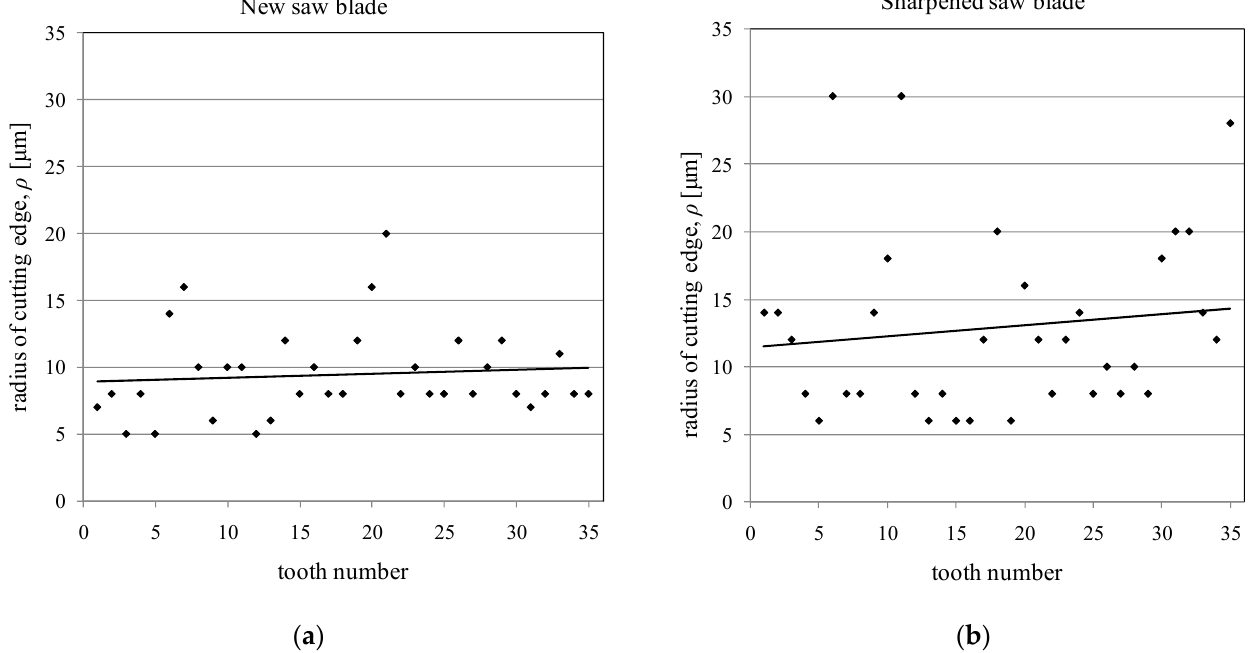
Figure 3. The radii of cutting edges determined from tooth images from both analysed saw blades: new saw blade ( a ) and sharpened saw blade ( b ).